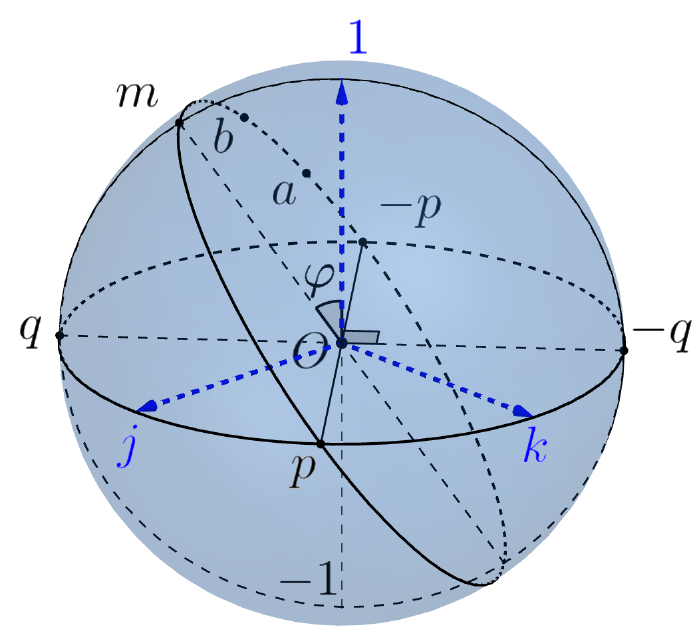
Figure 9. Listing’s